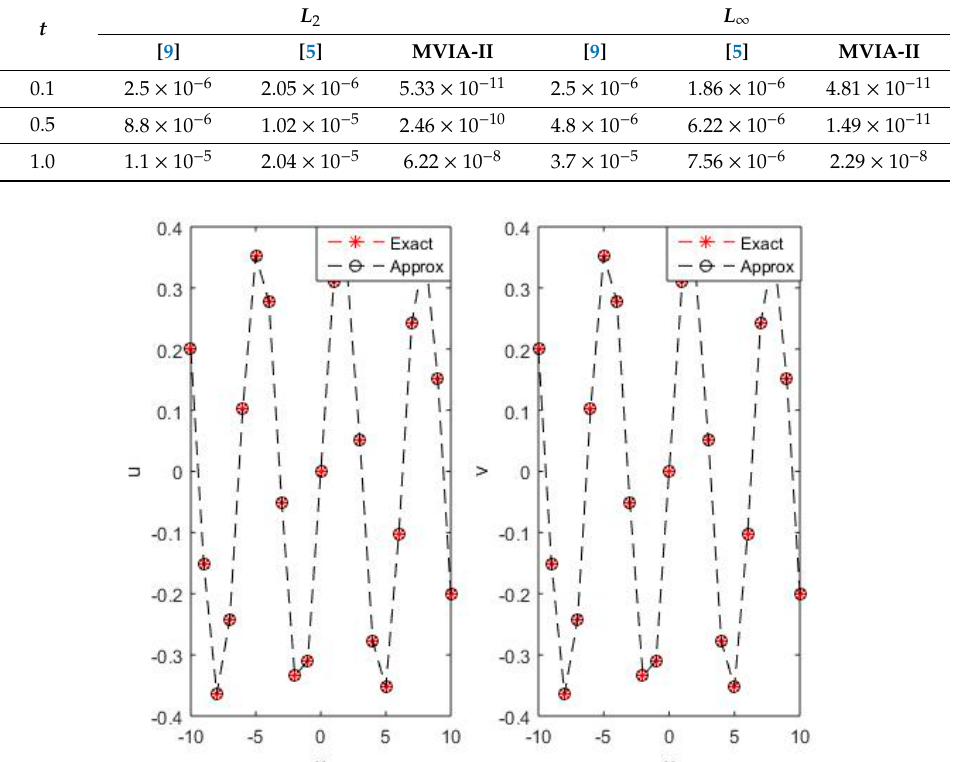
Figure 7. Comparison of the exact and approximate solution for 𝑢 and 𝑣 for 𝑡 = 1 for Test Problem 3.